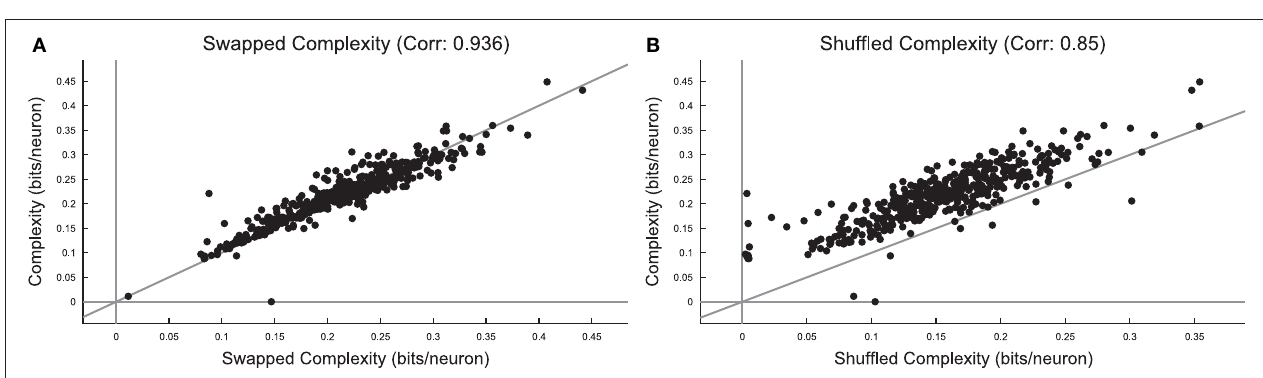
FIGURE 12 | Complexity is independent of precise spiking relationships in culture data, but dependent on firing rate. (A) Comparison of complexity in real data and complexity in spike swapped randomized data for each culture data set. Note the strong correlation between the complexity values and the fact that most cultures fell near the equality line. This indicates that spiking relationships (which are disrupted to some extent by spike swapping) did not strongly affect complexity. (B) Comparison of complexity in real data and complexity in shuffled data for each culture data set. Note that the complexity values were strongly correlated, but complexity in the real data tended to be greater than the complexity in the shuffled